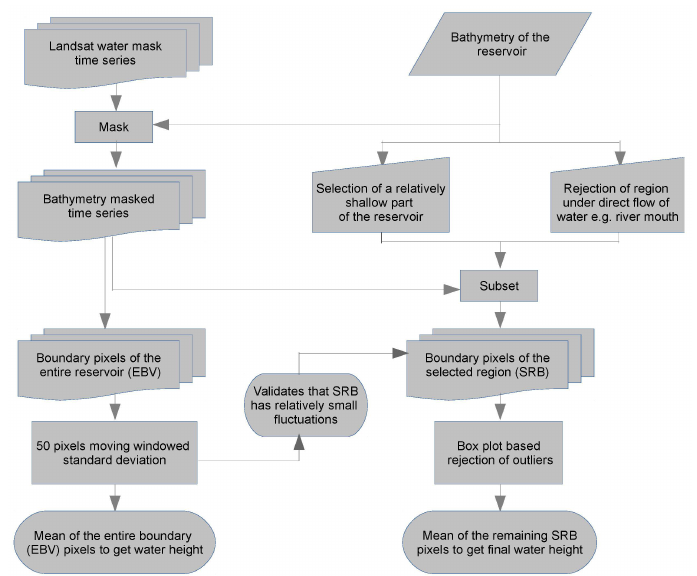
Figure 3. Algorithm of water level estimation in the LBV method: rectangular boxes indicate processes, trapezoids indicate the manual operation and multiple document boxes indicate the time series of the images.